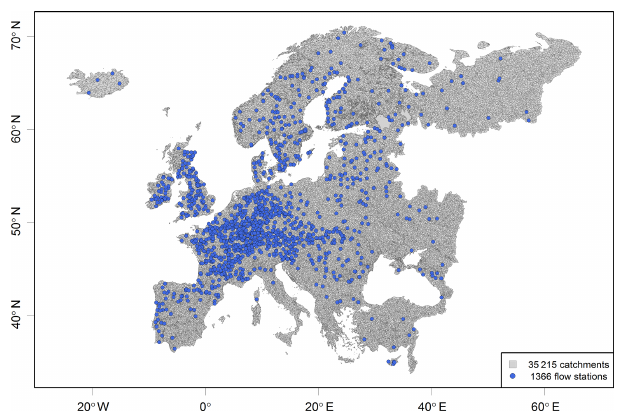
Figure 2. Spatial extent of the study showing catchment division and selected river